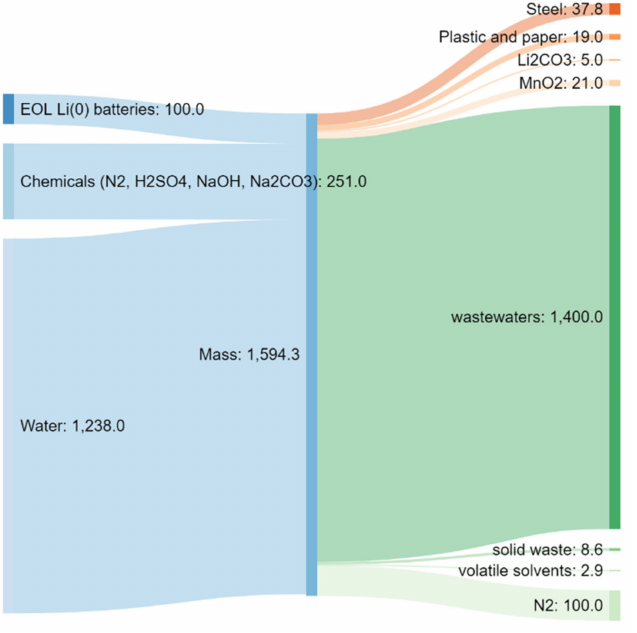
Figure 6. Sankey diagram of the LIFELIBAT